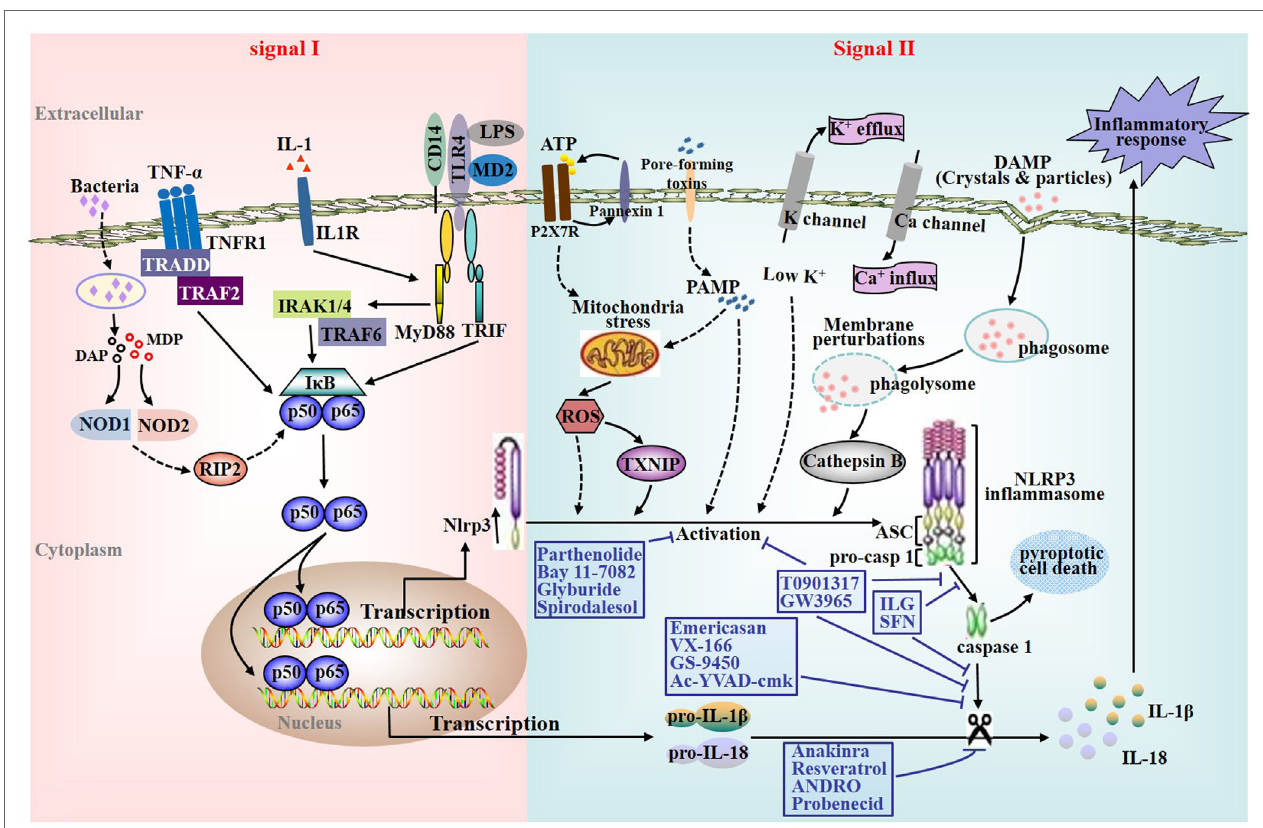
FigURe 1 | Nucleotide­binding oligomerization domain­like receptors family pyrin domain containing 3 (NLRP3) inflammasome activation and characterization of various pharmacological inhibitors of the NLRP3 inflammasome signaling cascade. Effective activation of the NLRP3 inflammasome requires a priming signal prior to or coincident with a secondary NLRP3­specific activating signal. First, NLRP3 inflammasome priming or initiating is accomplished by nuclear factor kappa B (NF­ κ B)­activating receptors including Toll­like receptors (TLRs), interleukin (IL)­1 receptor, tumor necrosis factor receptor, and the cytosolic pattern recognition receptor nucleotide­binding oligomerization domain 2 (signal I). Subsequently, the second signaling is provided by one of various agonists that triggers NLRP3­ specific activation, assembling of the NLRP3 inflammasome complex, and ultimately culminates in the activation of casp1 as well as the secretion of mature IL­1 β and IL­18 (signal II). So far, a variety of triggers with different properties have been shown for NLRP3 inflammasome activation. The diverse group of activators includes crystals and particles such as alum, silica, asbestos, monosodium urate that requires phagocytosis for activation, adenosine triphosphate (ATP) acting via its cell surface purinergic P2X7 receptor (ROS), and pore­forming toxins such as